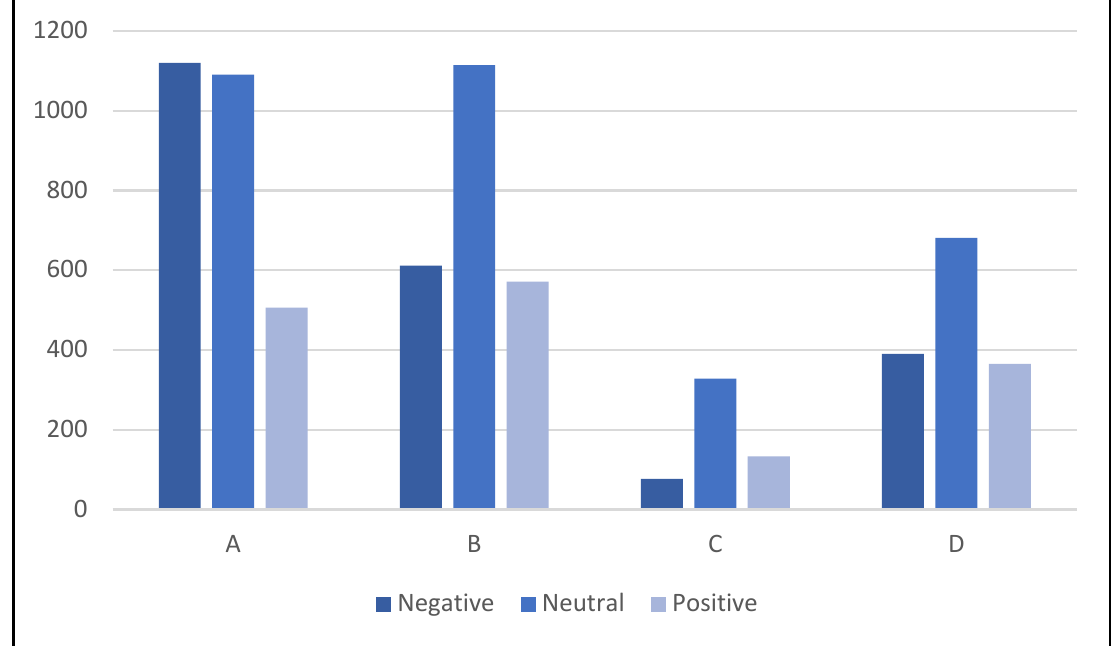
Figure 11. Comparison of scores for Company A, B, C and D.